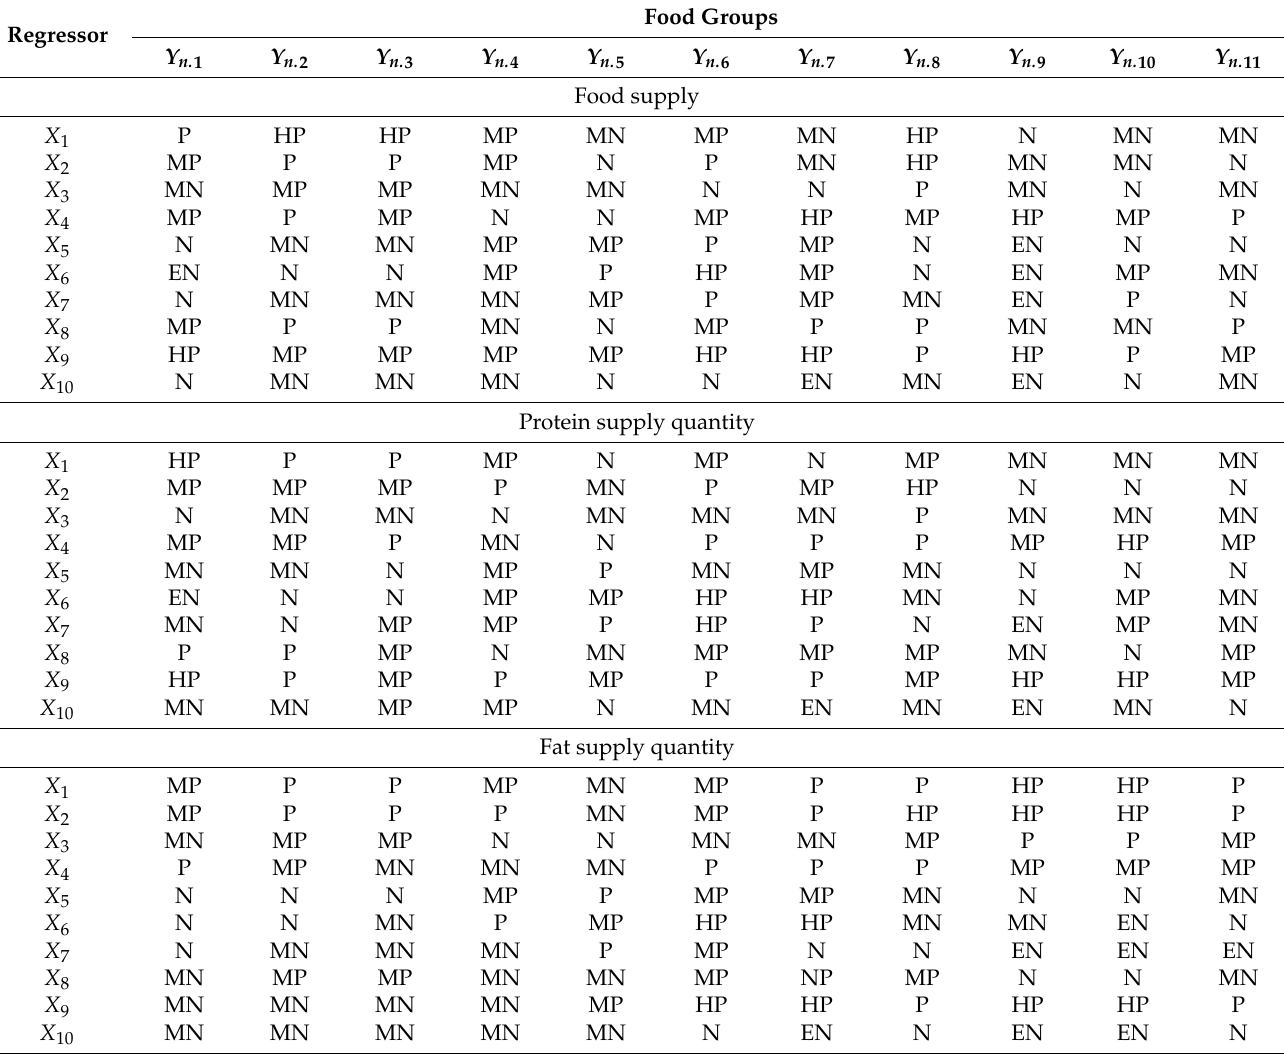
Table 8. The effects of X n on Y n in lower-middle-income economies. Food